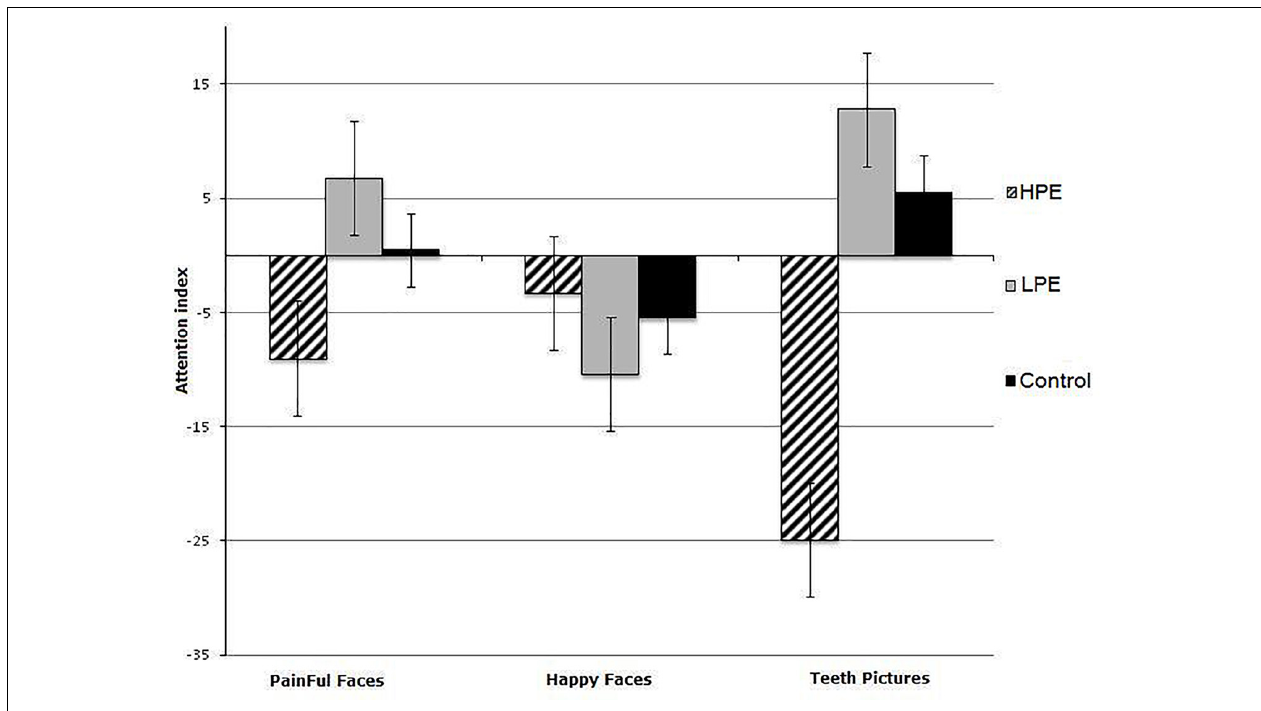
FIGURE 2 | Mean Reaction times to happy, pain, and teeth related pictures in High Pain Expectancy (HPE), Low Pain Expectancy (LPE), and control groups. TABLE 2 | Mean and SD of reaction times to congruent and incongruent trials during three dot-probe tasks for High Pain Expectancy group, Low Pain Expectancy group, and Control group. High pain expectancy group Low pain expectancy group Control